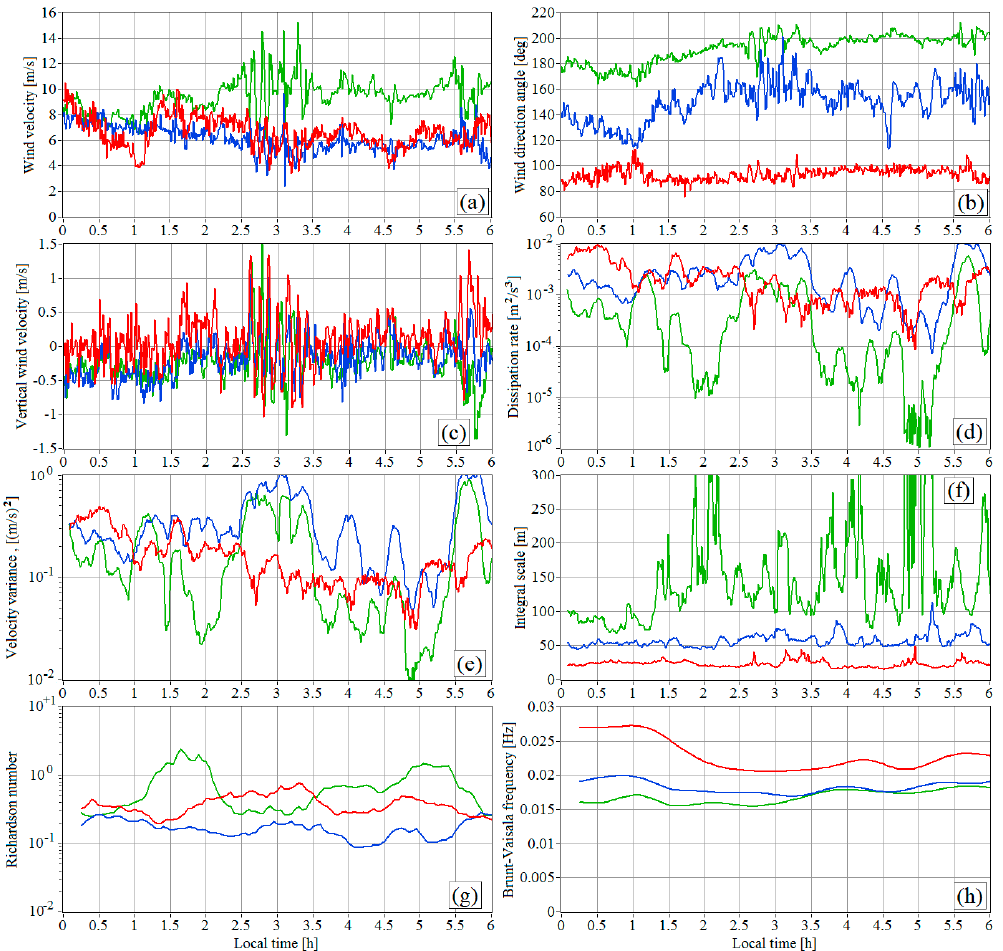
Figure 11. Time series of wind velocity ( a ), wind direction angle ( b ), vertical component of the wind vector ( c ), turbulent energy dissipation rate ( d ), variance of the radial velocity ( e ), integral scale of turbulence ( f ), Richardson number ( g ), and Brunt–Väisälä frequency ( h ) at heights of 91 (red curves), 325 (blue curves), and 506 m (green curves). The data for ( a – g ) are taken from Figure 10.